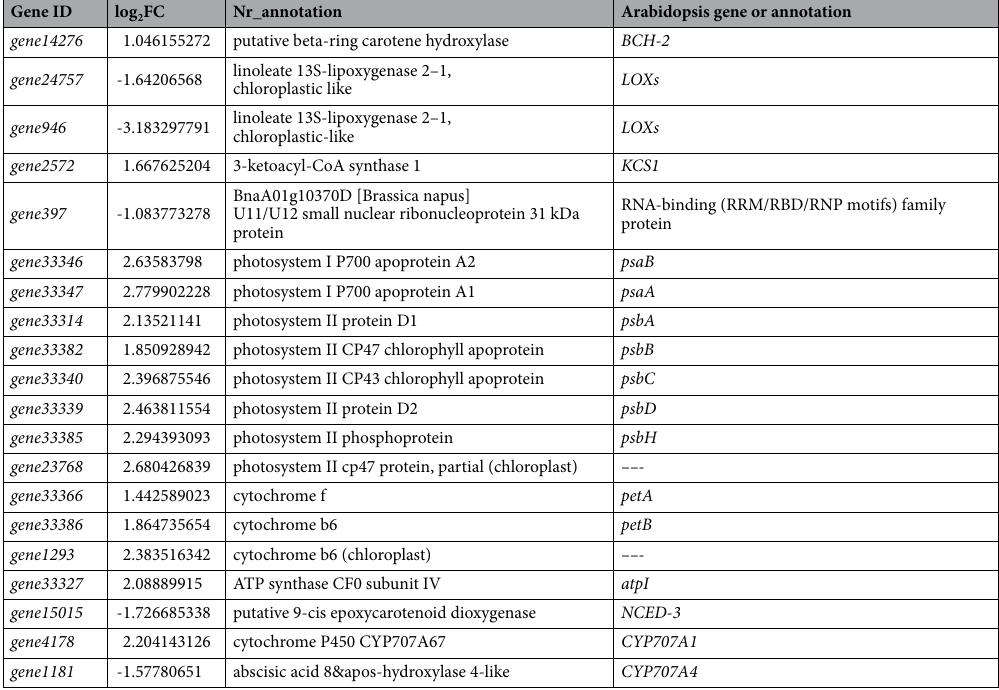
Table 3. DEGs related to carotenoid under elevated CO